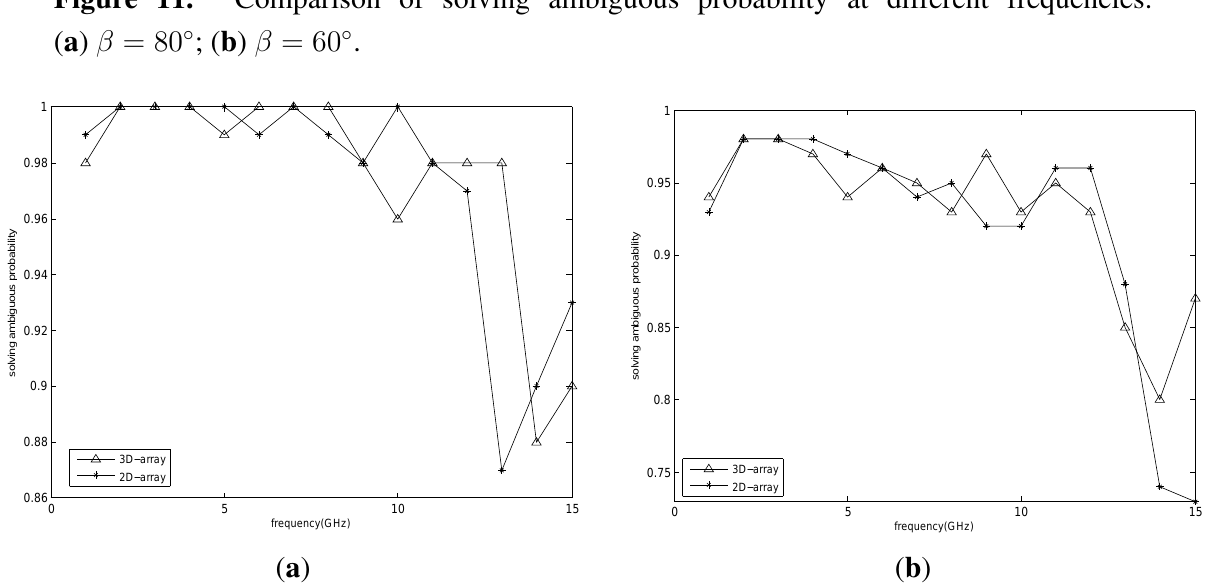
Figure 11. Comparison of solving ambiguous probability at different